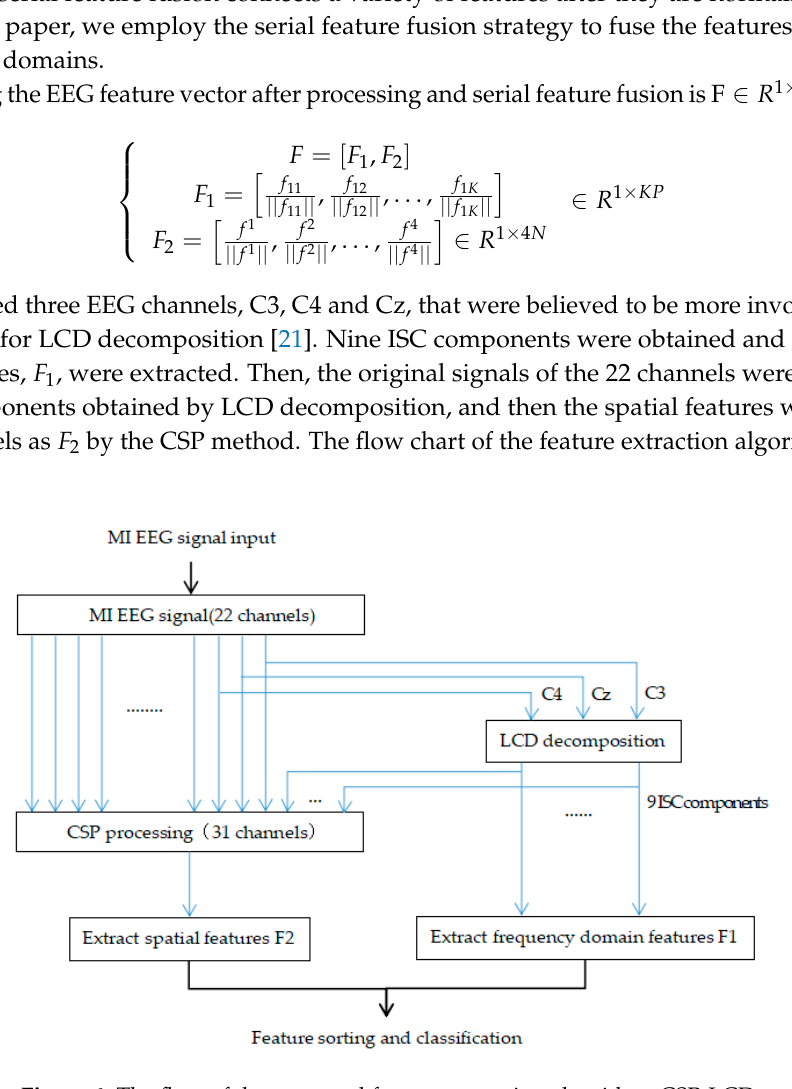
Figure 6. The flow of the proposed feature extraction algorithm, CSP-LCD.